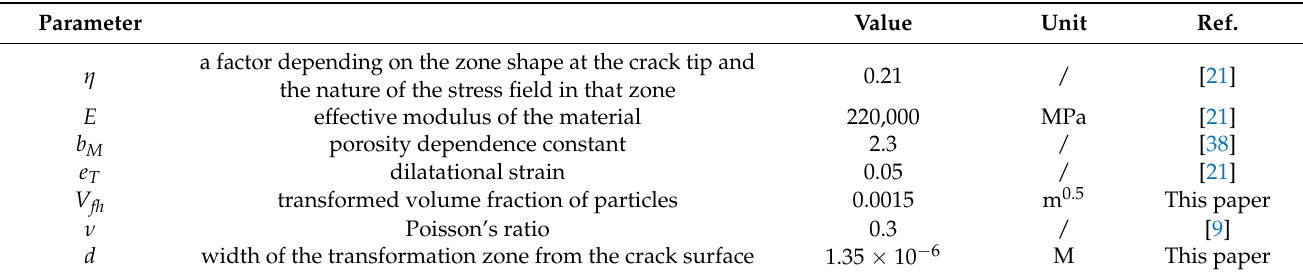
Table 3. Parameters used for modelling the R-curve behaviour by Equation (5) taken from [9,21,38] and experimental